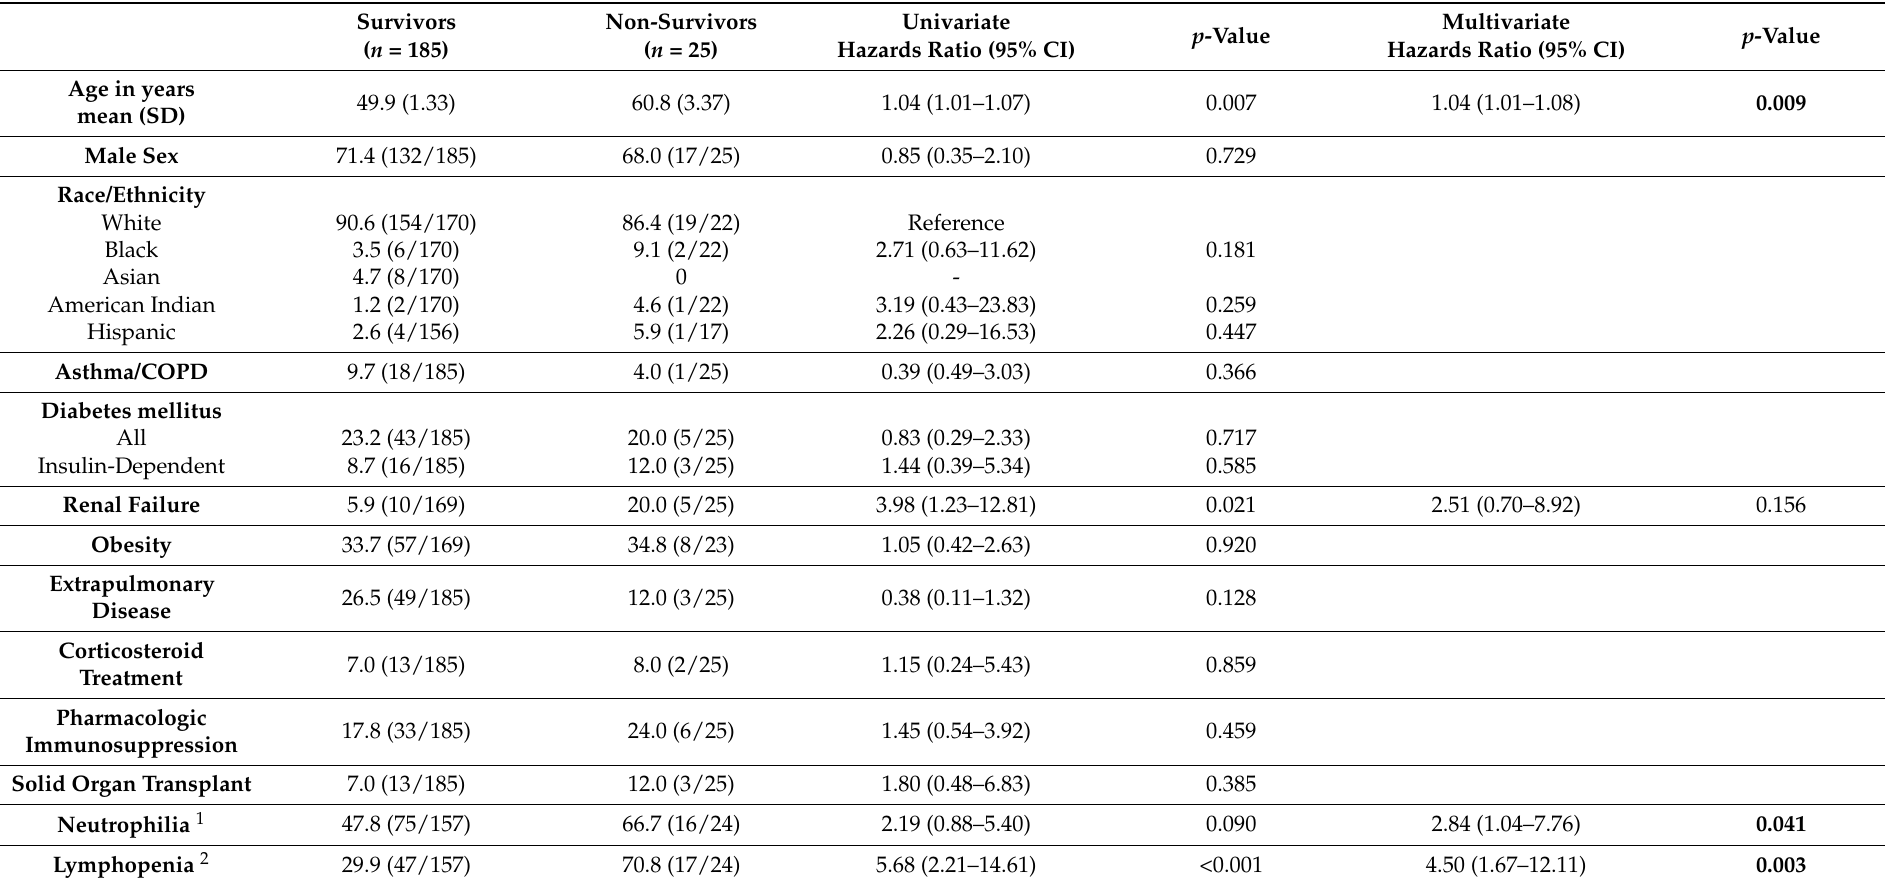
Table 3. Risk factors for 90-day